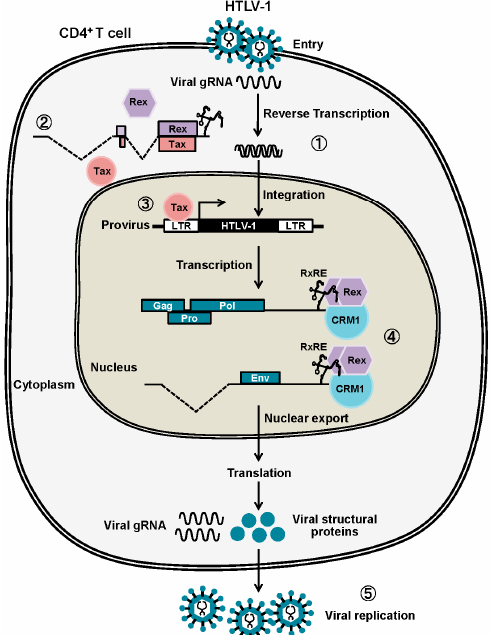
Figure 1. After HTLV-1 entry, the viral genomic RNA is reverse-transcribed and integrated into the host human genome (1). The viral mRNA from the provirus for the first-round of transcription is completely spliced to tax/rex mRNA by the cellular splicing machinery (2). Tax stimulates the transactivation of LTRs for further viral transcription, resulting in the gradual accumulation of Rex in the infected cell (3). Rex then starts exporting the unspliced and partially spliced viral mRNAs, encoding Gag, Pro, Pol, and Env, to the cytoplasm by binding to RxRE of viral mRNA (4),resulting in active viral replication (5). Due to active nuclear export of unspliced and partially spliced viral mRNA by Rex, that of tax/rex mRNA is eventually reduced to enter the